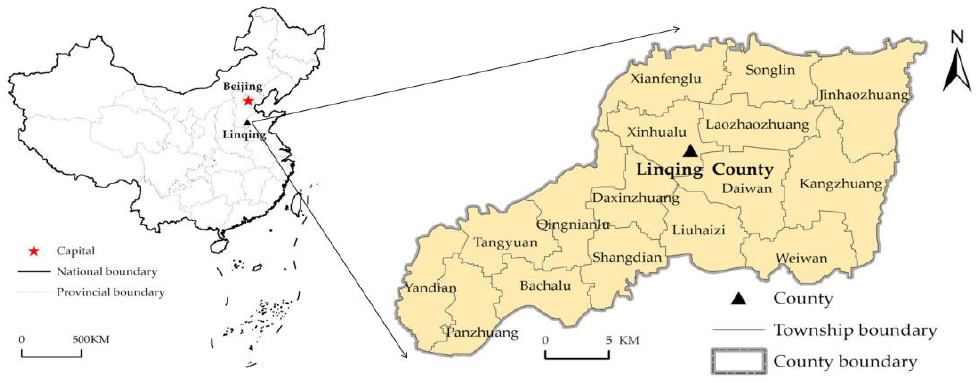
Figure 2. Location of the study area.